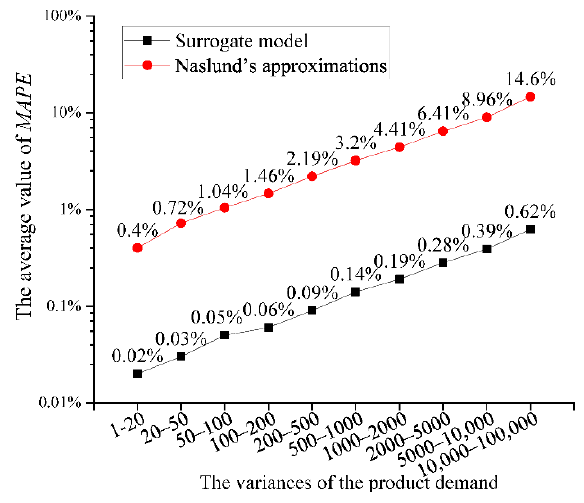
Figure 5. The comparison of Naslund’s approximation and surrogate model.